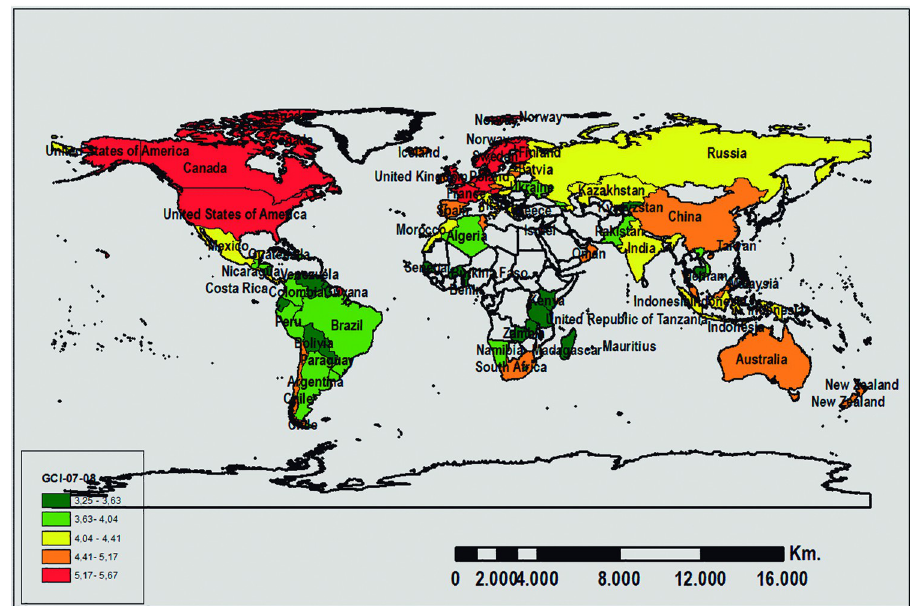
Fig 2. Geographic distribution of the WEF-GCI scores for 2007–08. Source: Prepared by authors using ArcGIS software.